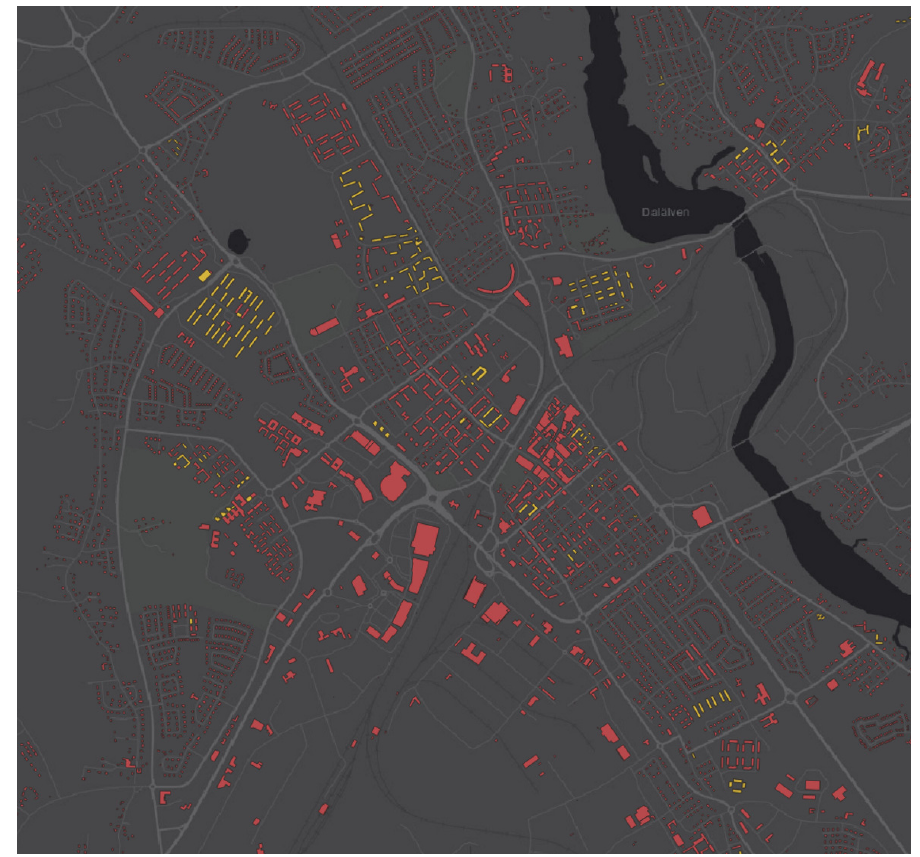
Figure 11. Borlänge building footprints (in red) and this study’s building footprints (in